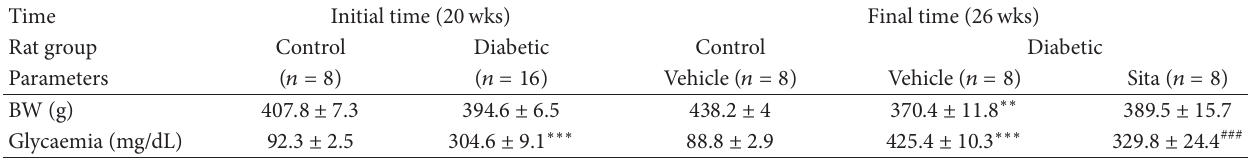
Table 1: Body weight and glycaemia in the control and diabetic ZDF rats, nontreated and treated with sitagliptin for 6 weeks. Time Initial time (20 wks) Final time (26wks) Rat group Control Diabetic Control Diabetic Parameters ( 𝑛 = 8 ) ( 𝑛 = 16 ) Vehicle ( 𝑛 = 8 ) Vehicle ( 𝑛 = 8 ) Sita ( 𝑛 = 8 ) BW (g) Glycaemia (mg/dL) 92.3 ±